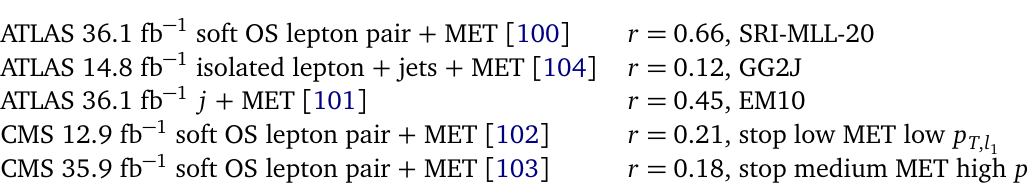
Table 5: Summary of constraints on benchmark point [ 3 ] from the most sensitive 13 TeV searches implemented in C HECK MATE at the LHC. SRI1, EM2, and the stop low MET low p regions are already described in Table 6. 2j-1200 imposes a high T , (cid:96) 1 MET cut , requires at least two hard jets with invariant mass larger than 1.2